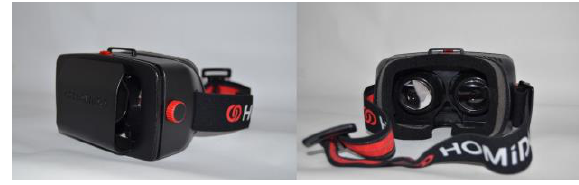
Figure 2. Homido VR.